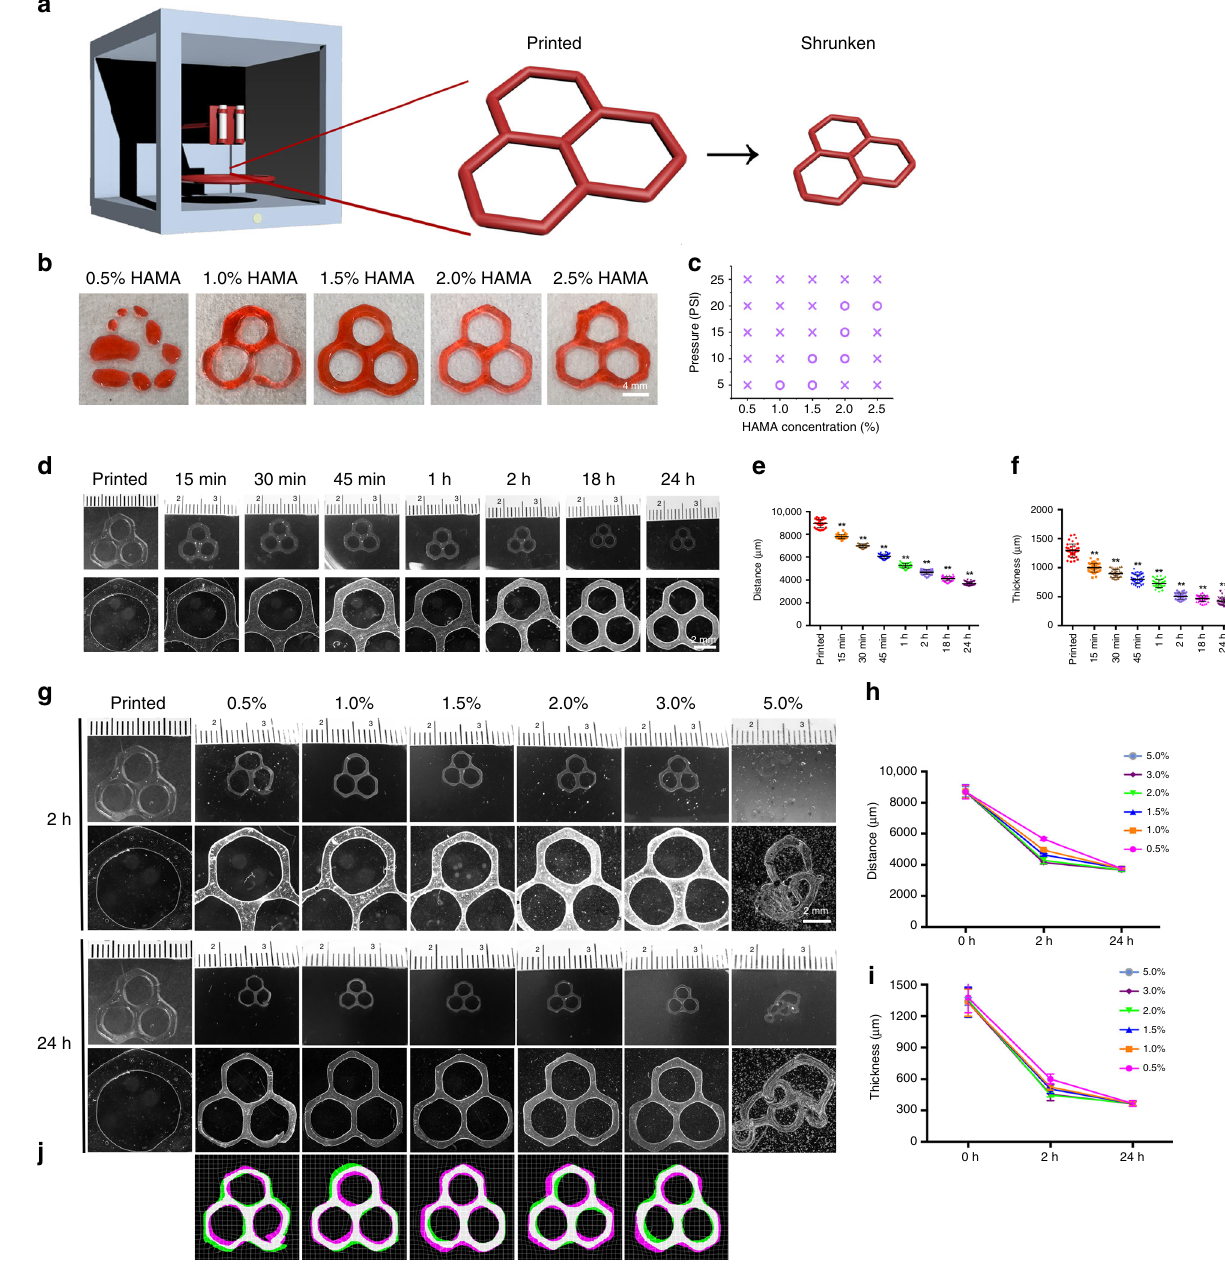
Fig. 2 Direct extrusion printing of HAMA constructs and their shrinking behaviors. a Schematics showing the concept of shrinking printing, where a printed hydrogel structure is post-treated to reduce its size and achieve higher resolution. b , c Printability mapping of HAMA inks at different concentrations and extrusion pressures. d Photographs (upper) and micrographs (lower) showing size changes of printed HAMA hexagons (2.0 w/v%) immersed in 2.0 w/v% HM w chitosan dissolved in 1.0 v/v% acetic acid aqueous solution during the 24h shrinking process. e , f Corresponding quantitative analyses of size changes of the printed HAMA hexagons (2.0 w/v%), include e side-to-side distance and f thickness, during the 24h shrinking process. g Photographs (upper) and micrographs (lower) showing size changes of printed HAMA hexagons (2.0 w/v%) at 2 h and 24 h of shrinking in different concentrations of HM w chitosan (0.5 – 5.0 w/v%) dissolved in 1.0 v/v% acetic acid aqueous solution, h , i Corresponding quantitative analyses of size changes in h side-to-side distance and i thickness. j Vector- fi eld maps comparing the 24-h shrinking images (magenta) to the corresponding 2-h shrinking images (green) by a B-spline-based non-rigid registration algorithm, where the overlaps appear in white and the grids show local distortions. Note that the 2-h shrinking images have been rescaled to match the sizes of the 24-h shrinking images to enable comparisons. ** P < 0.01; one-way ANOVA ( e , f , compar e d with the values of corresponding as-prepared samples); mean ± s.d. ( e , f , n = 40; h , i , n = retain their shape and shrank to 40.8 ± 1.8% in side-to-side distance and 24.1 ± 2.6% in thickness as compared to the original dimensions, since the viscosity of Q. chitosan solution was much